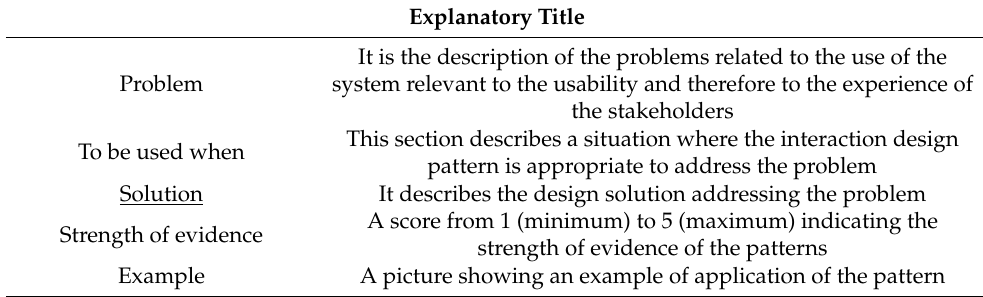
Table 2. Structure of the